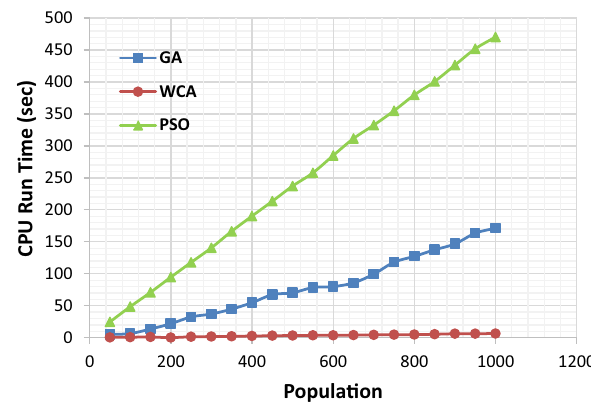
Fig. 5 Optimized oil production rate in different populations as esti- mated by WCA, PSO and GA algorithms